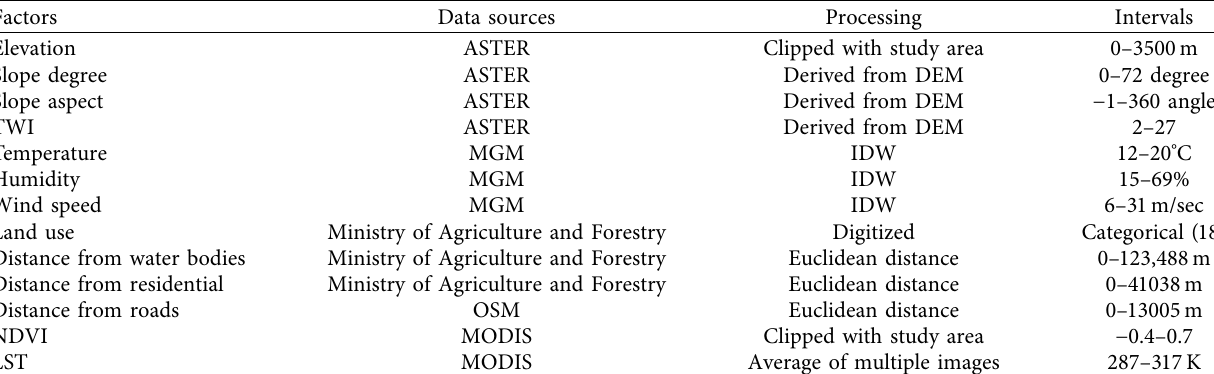
Figure 5: Forest fre conditioning factors: (a) land use, (b) distance from roads, (c) NDVI, and (d) LST. Table 3: Selected fre ignition factors, data sources, data processing, and